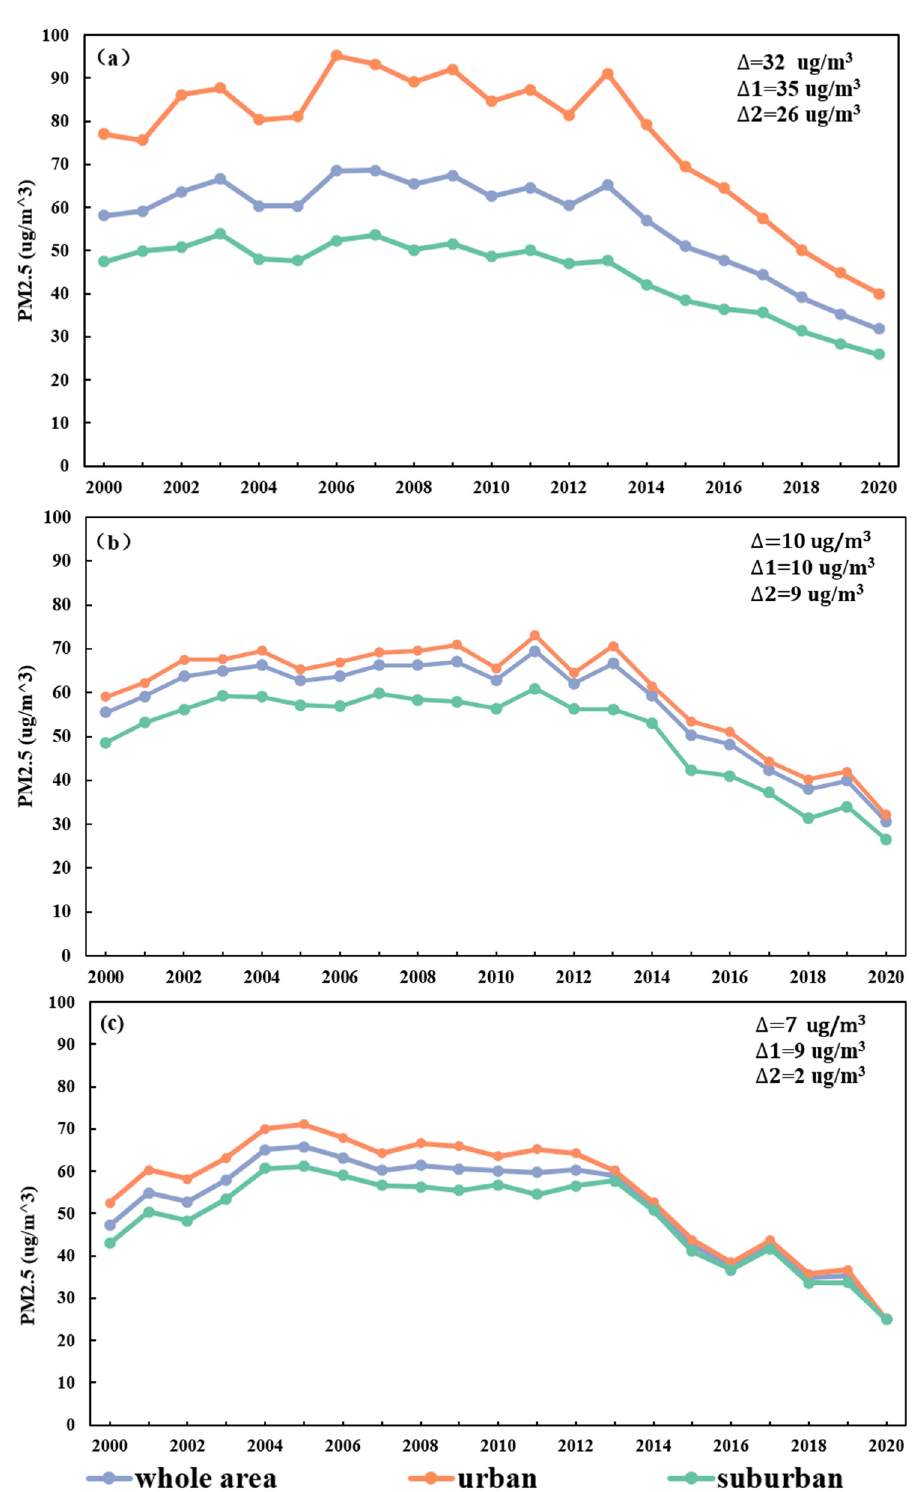
Figure 3. The PM 2.5 concentrations ( μ g/m 3 ) in the whole region as well as urban and suburban areas from 2000 to 2020 in ( a ) BTH, ( b ) YRD, and ( c ) PRD. In BTH, the highest PM 2.5 concentration of 92 μ g/m 3 occurred in the urban area in 2006, and the lowest PM 2.5 concentration of 26 μ g/m 3 happened in the suburban area in 2020. Before 2013 the PM 2.5 difference between urban and suburban areas was 35 μ g/m 3 , and the difference between them after 2013 was 26 μ g/m 3 . In YRD, the highest PM 2.5 con-